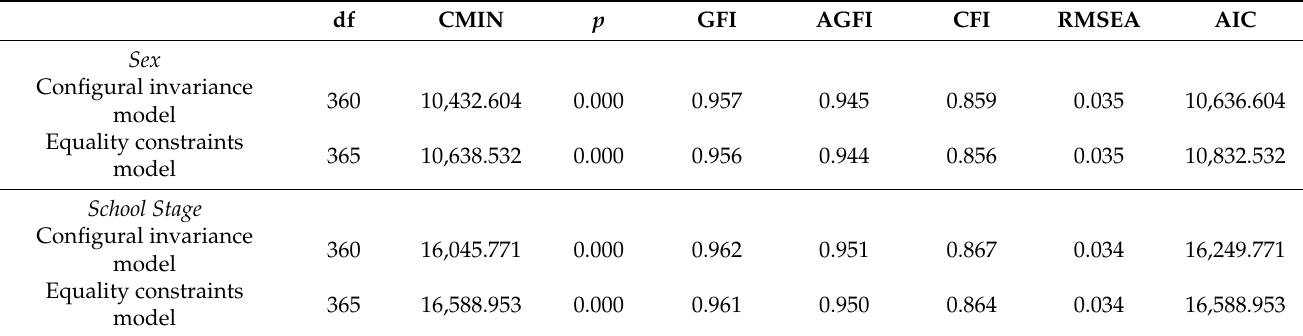
Table 3. Goodness-of-fit indices for each structural equation